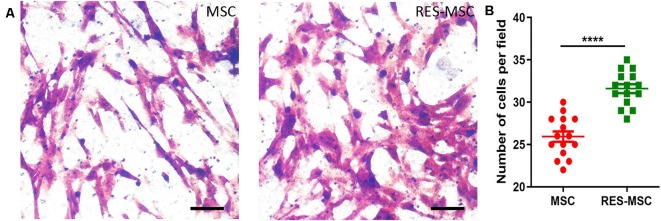
Effect of resveratrol on the migration of hUC-MSCs. (A) The hUC-MSCs that migrated to the bottom of the transwell insert were stained with crystal violet. Scale bars = 50 μm. (B) Graphical representation of the quantification of migrated cells. The number of migrated cells was counted using five random fields per well. Each experiment was repeated thrice (n = 15). Data were presented as mean ± SEM (t-test: ****indicates p < 0.0001; MSC vs. RES-MSC). MSC, human umbilical cord-derived mesenchymal stem cells; RES-MSC, human umbilical cord-derived mesenchymal stem cells pretreated with 2.5 μM resveratrol for 6 days; SEM, standard error of mean.